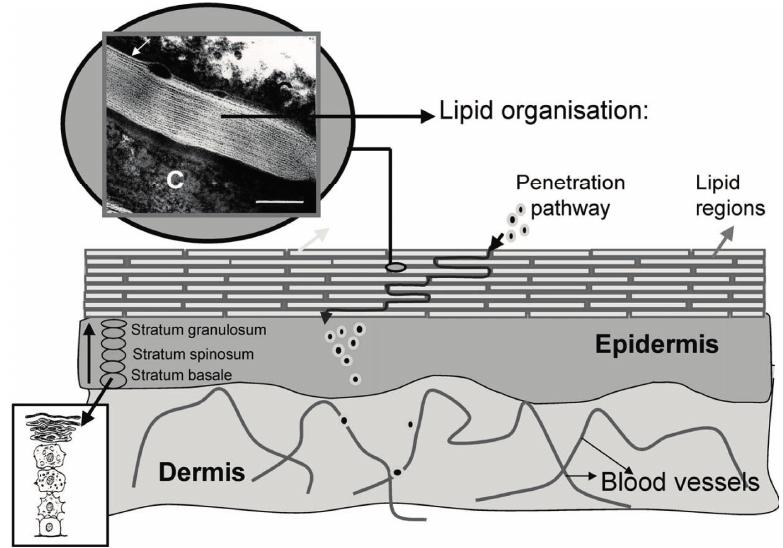
Figure 1. Architecture of the Epidermal Barrier. This schematic of the skin in cross section illustrates the architecture of the epidermal barrier. Keratinocyte maturation occurs as cells progress to the stratum corneum, at which time they differentiate into corneocytes. The corneocytes are surrounded by extracellular lipids and cross-linked proteins. C=a micrograph showing a corneocyte filled with keratin. Scale bar = 100 nm. Adapted with permission from Elsevier, 2003